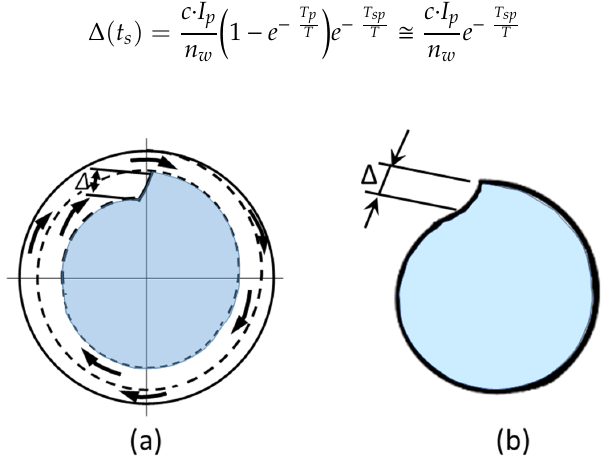
Figure 18. Roundness error caused by the residual depth of cut. ( a ) Work rotation during infeed grinding; ( b ) Step-roundness.